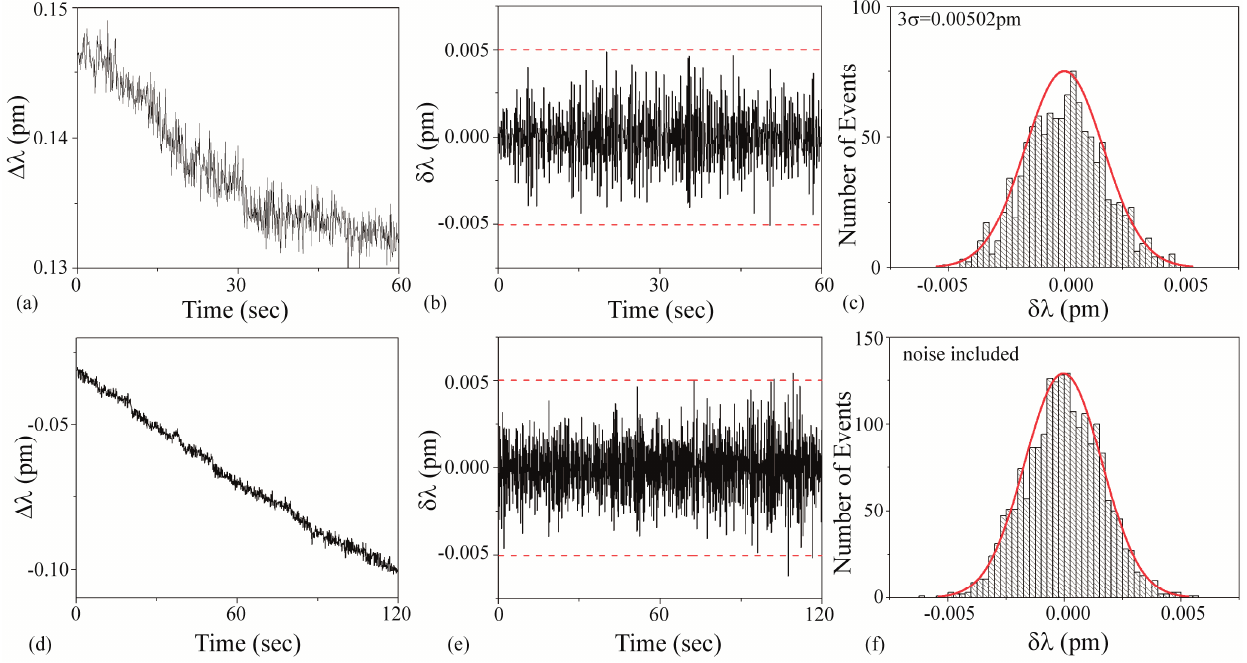
Figure 5. Cat solution: ( a – c ) background and ( d – f ) detection experiments. ( a )